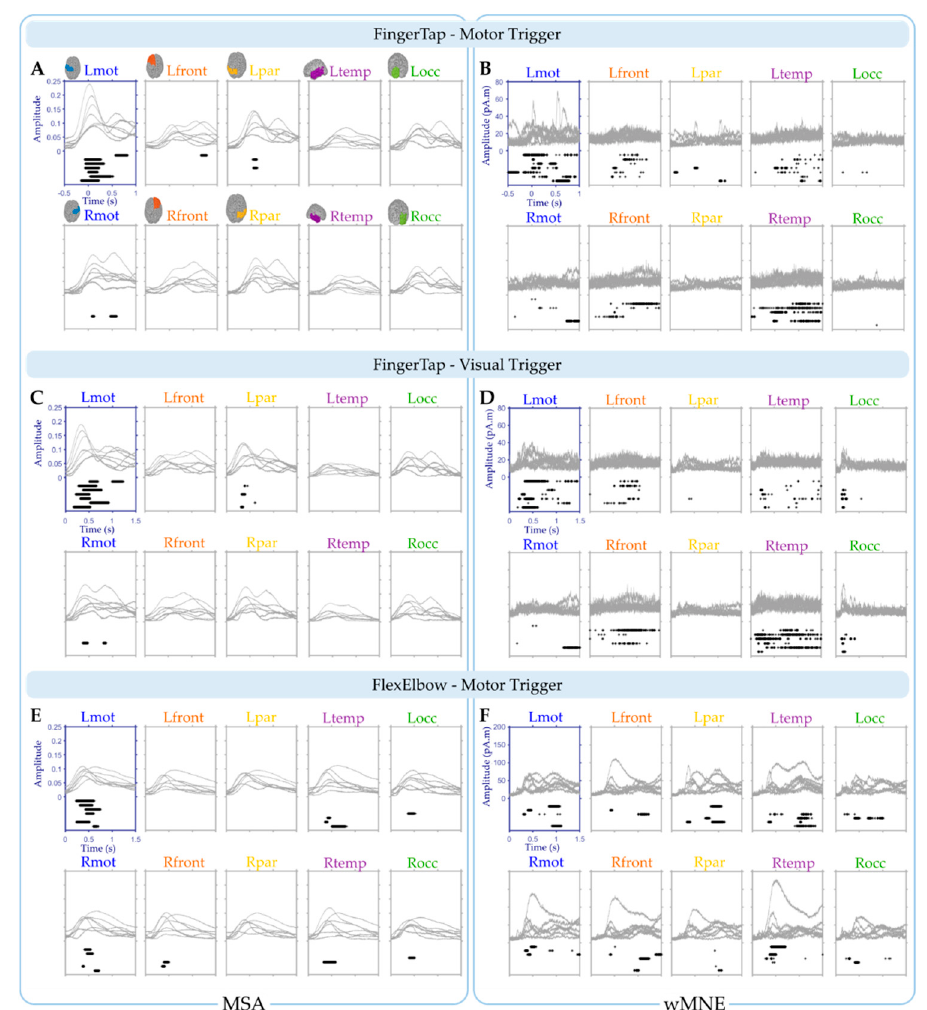
Figure 5. Participants’ mean absolute value of activity for the ten regions of interest using the MSA (MPC values) ( A ), ( C ), ( E ) and the wMNE method (current values) ( B ), ( D ), ( F ). Brain activations were triggered on the motor response ( A ) and ( B ) and on the visual cue ( C ) and ( D ) for the “FingerTap” experiment and on the visual cue only for the “FlexElbow” task ( E ) and ( F ). Each grey curve corresponds to the values obtained for a given participant during a specific task. For each region, significant time points are shown by black asterisks displayed below the curves (one row by participant).